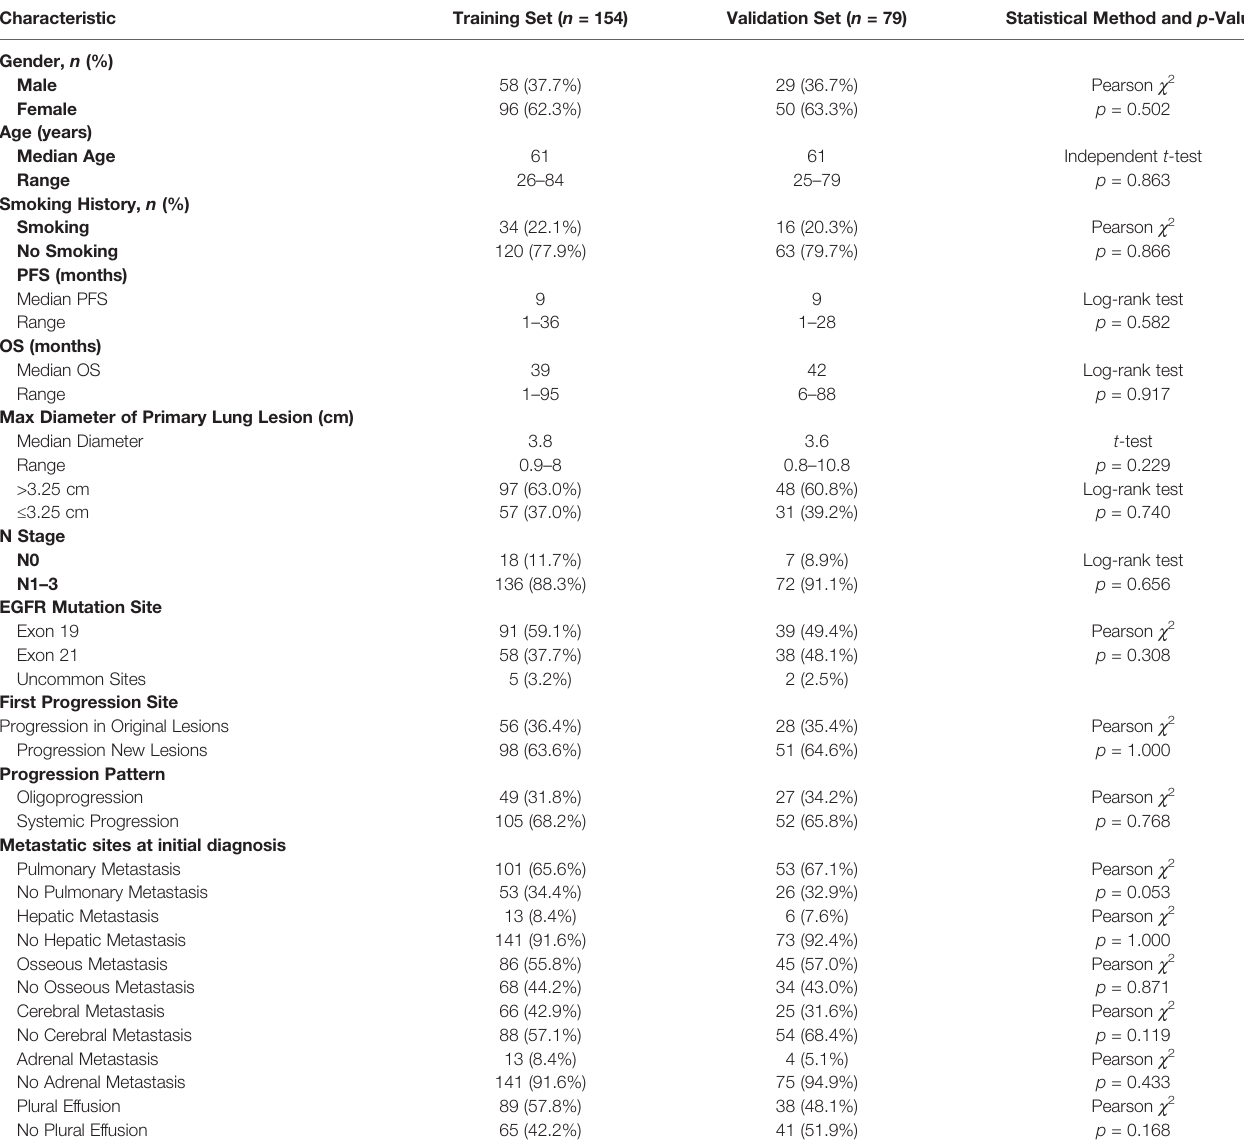
TABLE 2 | Comparison of clinical characteristics of patients between training set and validation